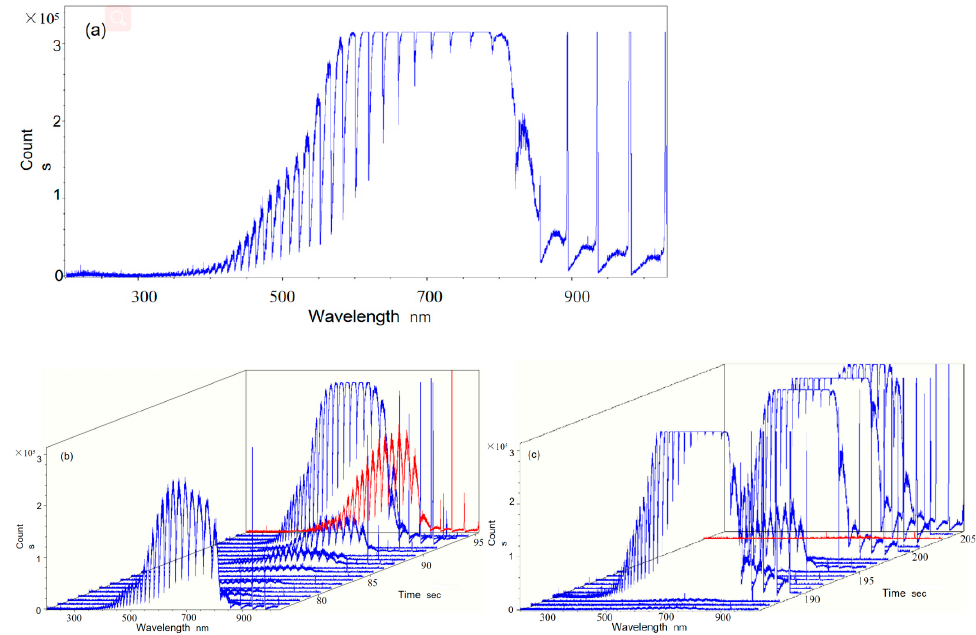
Figure 9. Spectral distribution of the additive manufacturing process of 30CrMnSiNi2A steel under the laser power of 1200 W, ( a ) high intensity distribution of the visible wavelength, ( b ) rapidly increasing spectral intensity at the initial stage of laser additive manufacturing, ( c ) stable spectral dynamic distribution in the stable stage of laser additive manufacturing, the intermediate interval is the state when the laser is shut down.